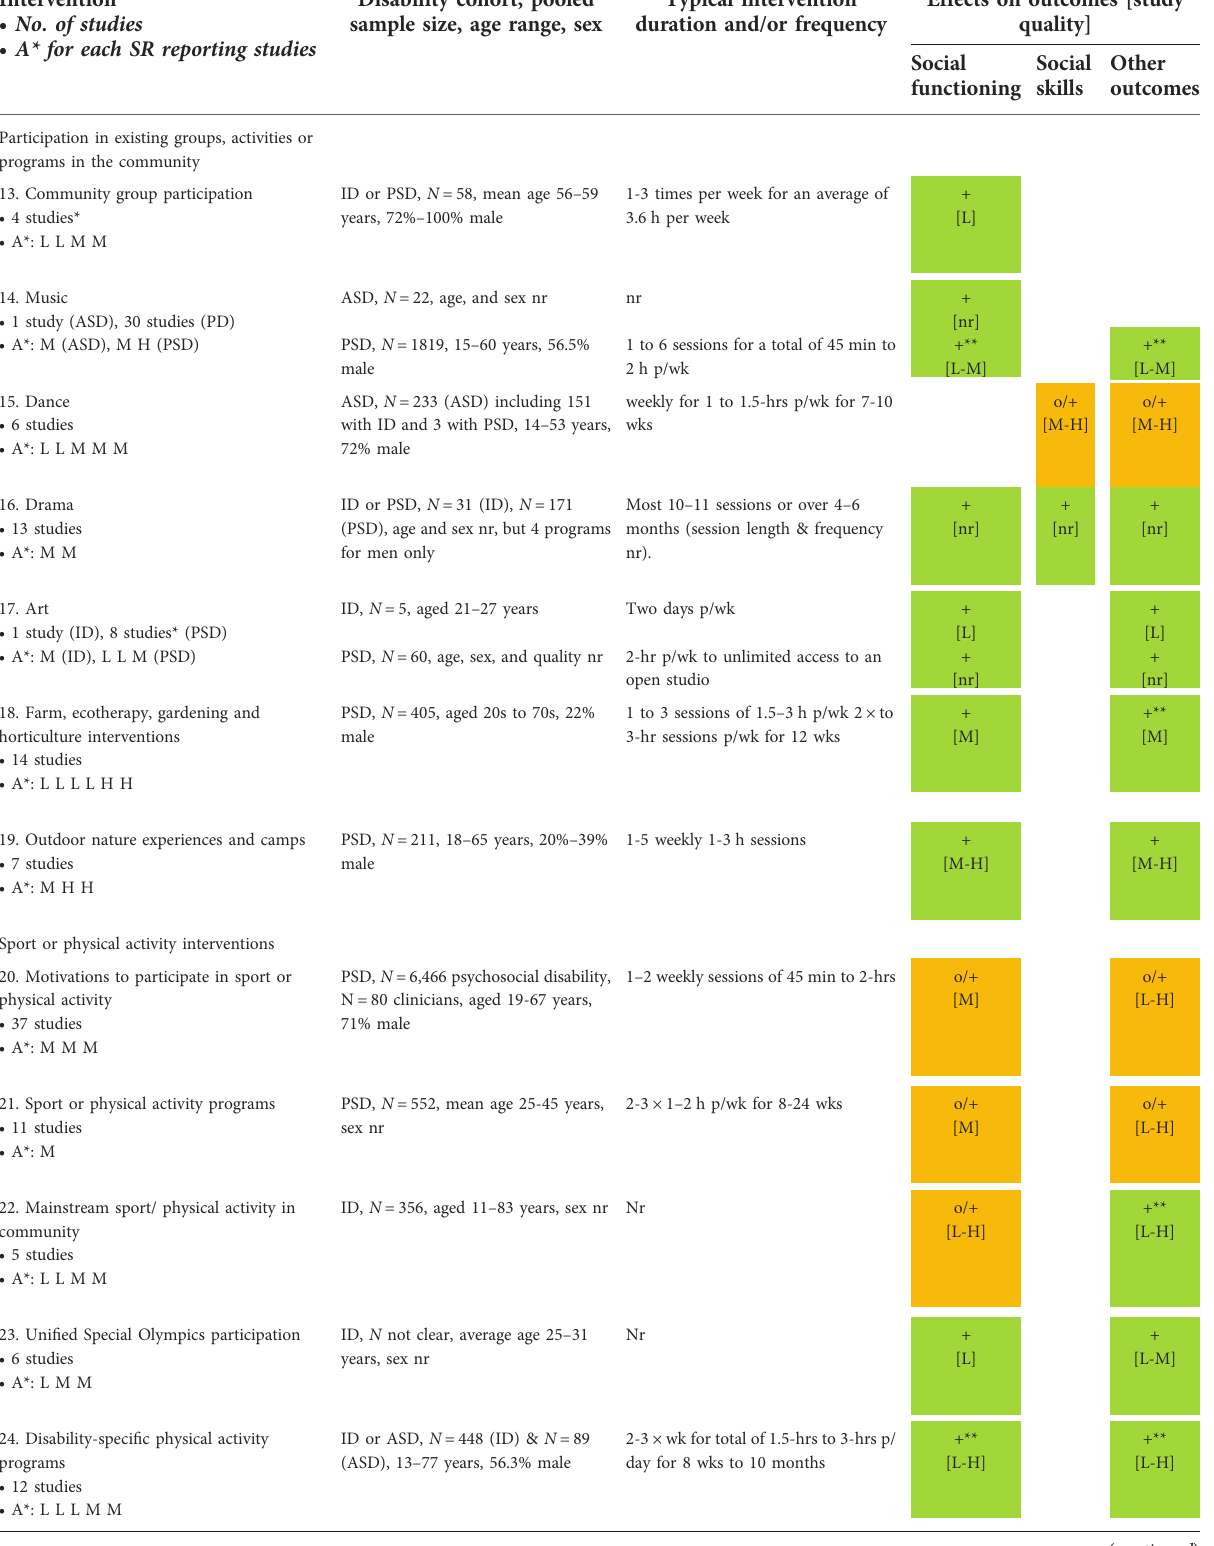
TABLE 3 Overall effects of taking up opportunities for participation on participation and other outcomes, including AMSTAR quality rating of the SRs and quality of the original studies. Intervention (cid:129) No. of